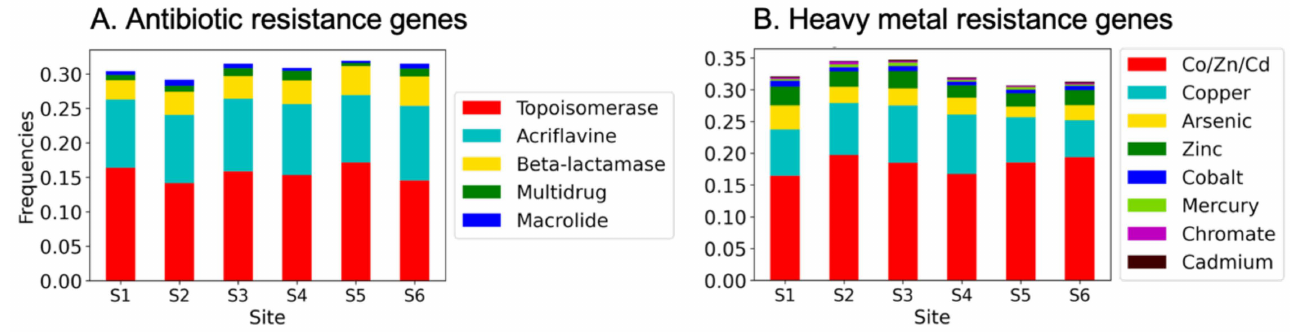
Figure 3. ( A ) Antibiotic and ( B ) heavy metal resistance gene frequencies in the canal samples. Keywords for ARG and HMR resistance genes are in the legends in the corresponding figure panel. Shown are frequencies in genes identified by MG-RAST as related to “virulence, disease and defense”. Frequencies were determined by dividing the number of identified genes by the total number of VDD genes at each site. The total numbers of genes in the VDD category at each site: S1 = 4056; S2 = 2088; S3 = 2463; S4 = 1283; S5 = 2003; S6 =